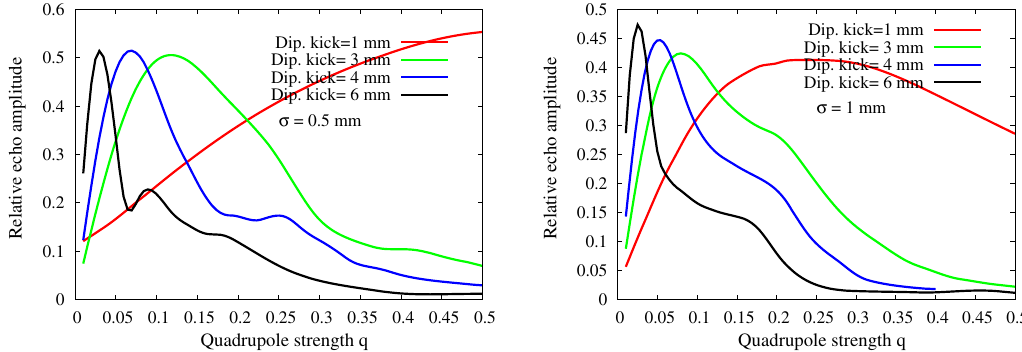
FIG. 6. Relative echo amplitude vs the quadrupole strength from simulations for different dipole kicks. Left: initial beam size at the BPM σ ¼ 0 . 5 mm. Right: σ ¼ 1 mm. In both plots the maximum echo amplitude is not significantly affected by increasing the dipole kick, but the value of q changes opt